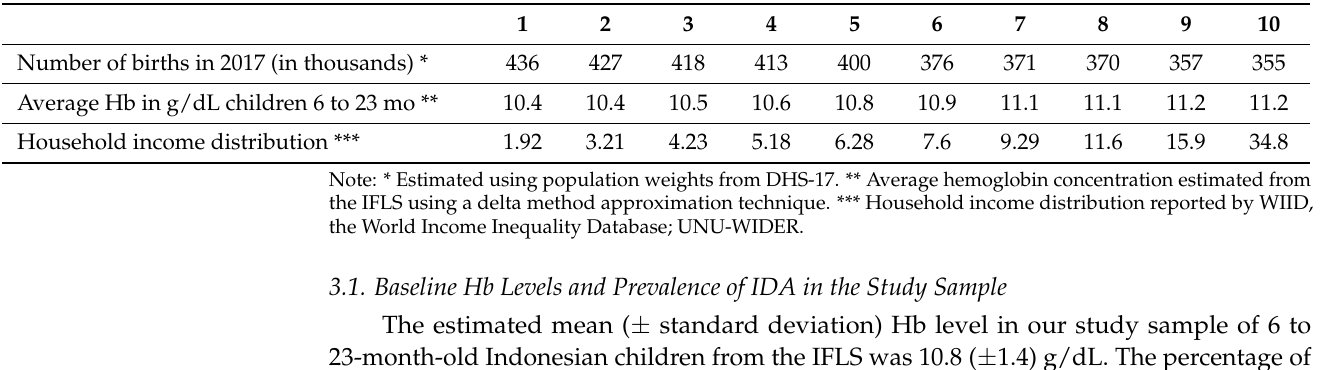
Table 1. Baseline characteristics of the population in the model by socioeconomic decile 1 to 10.